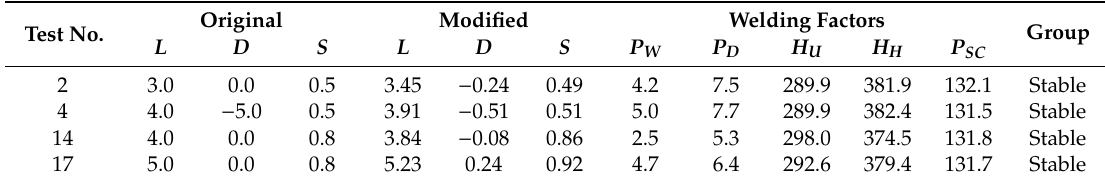
Table 13. Results of welding parameters modified by optimization process.